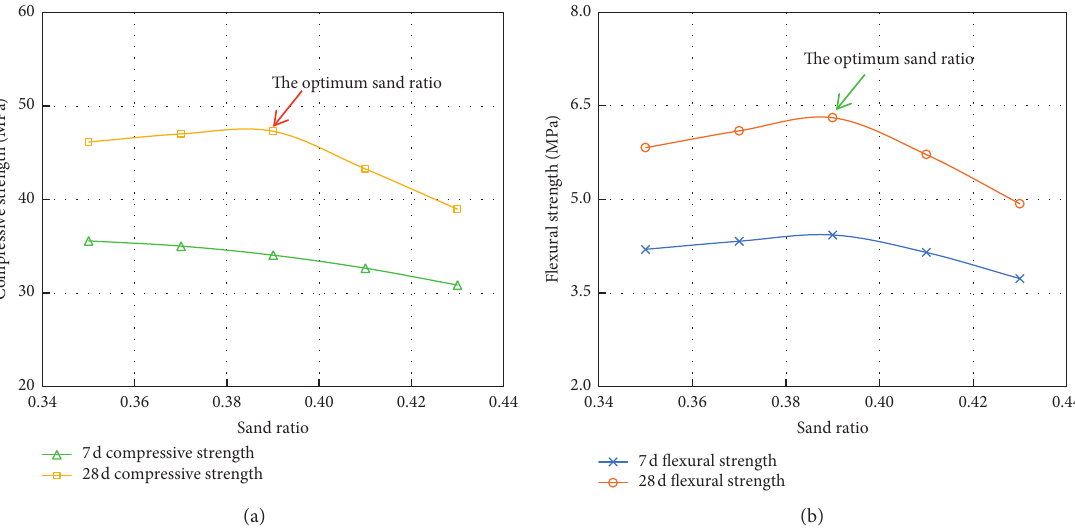
Figure 5: Strength of recycled aggregate concrete with different sand ratios. (a) The compressive strength. (b) The flexural tensile strength.